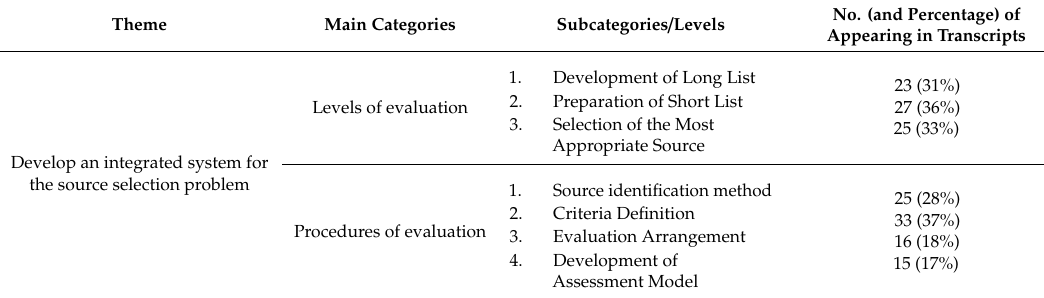
Table 2. The content analysis of